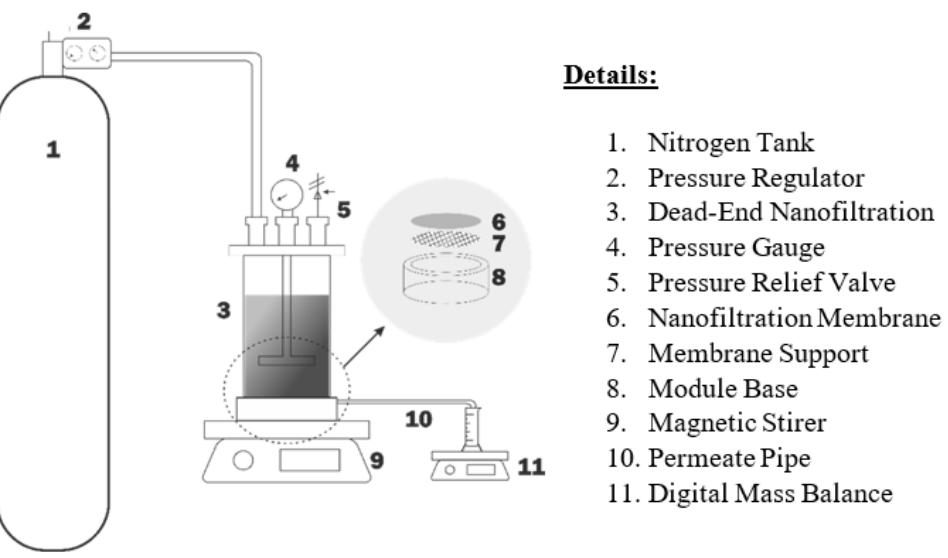
Figure 1. Experimental apparatus for